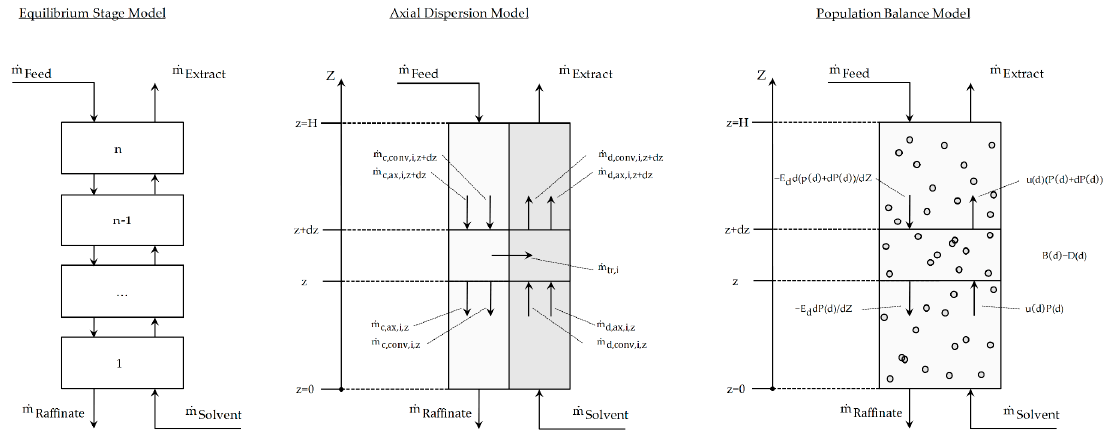
Figure 4. Model balance volumes for distributed plug flow model and schematic comparison to stage and population balance model approach.